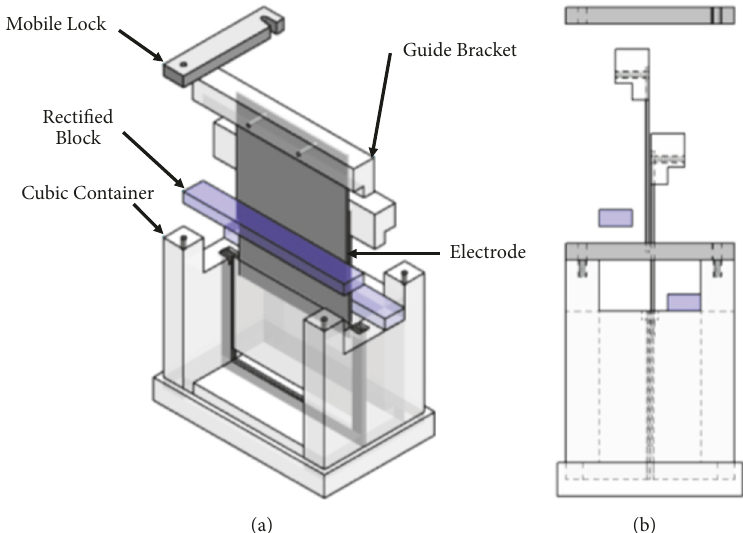
Figure 1: (a) Isometric exploded view and (b) side view of the electrolytic cell [29,